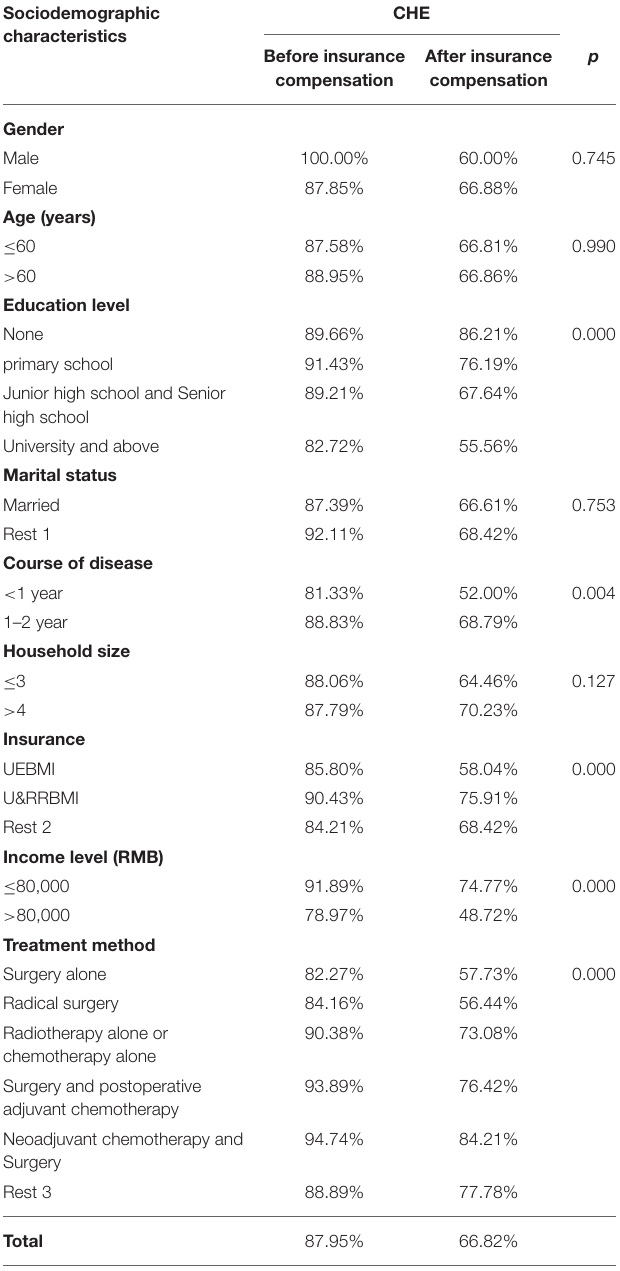
TABLE 2 | Incidence of CHE before and after insurance